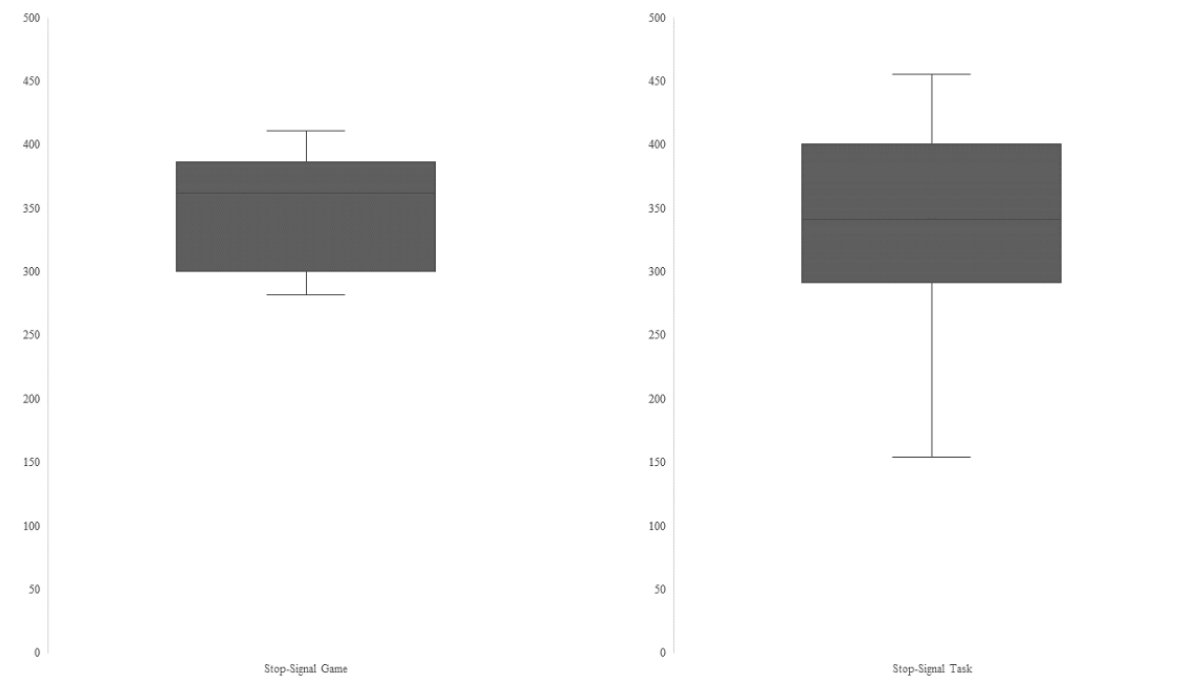
Table 7. Mean error rates and accuracy in their relative proportion to the total trial count dependent on the study and task type for study 2.